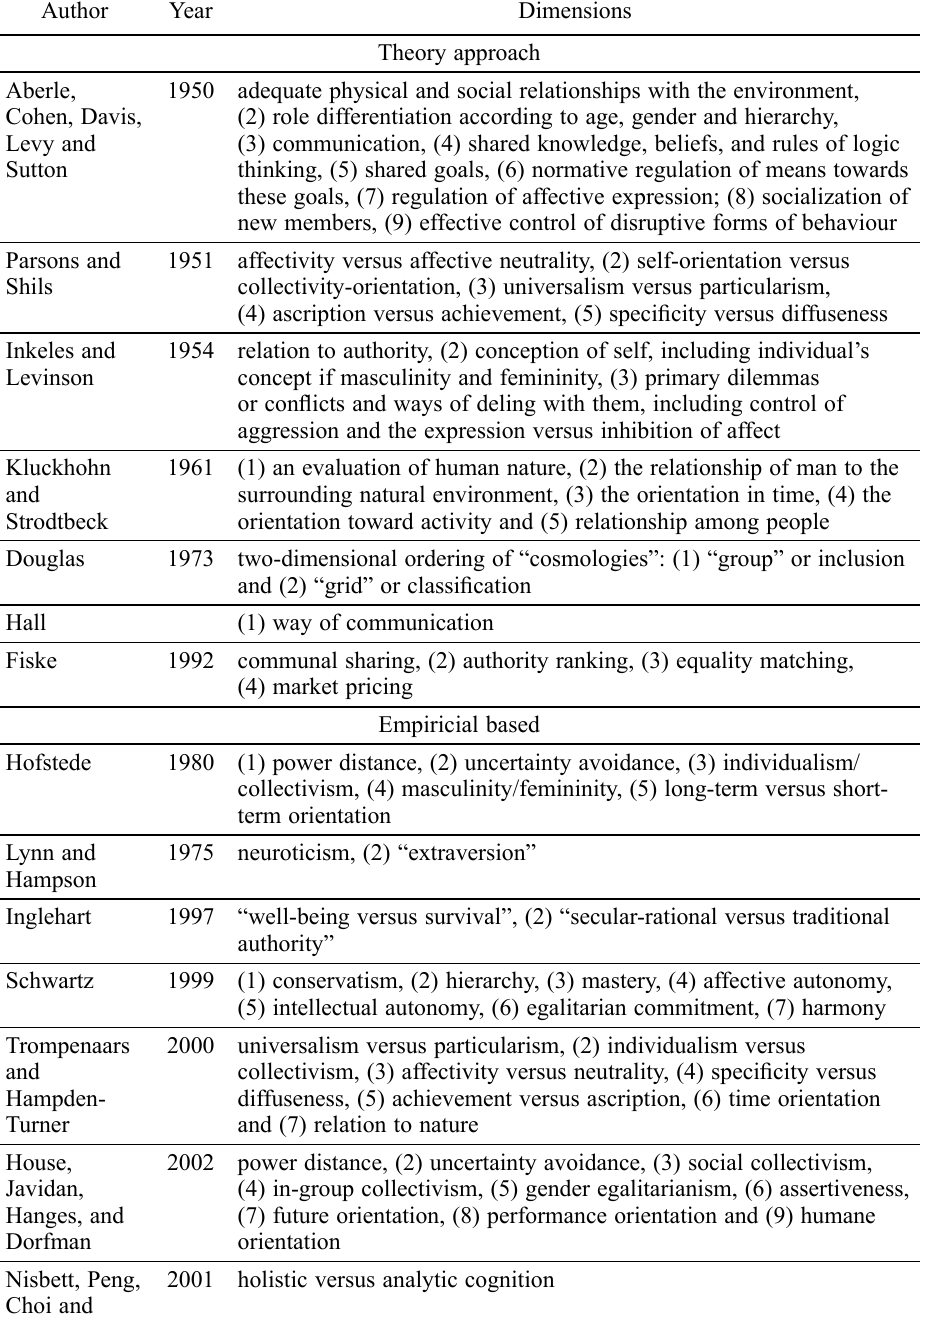
Table 1. Overview of national culture’s dimensions: theory and empirical based Author Year